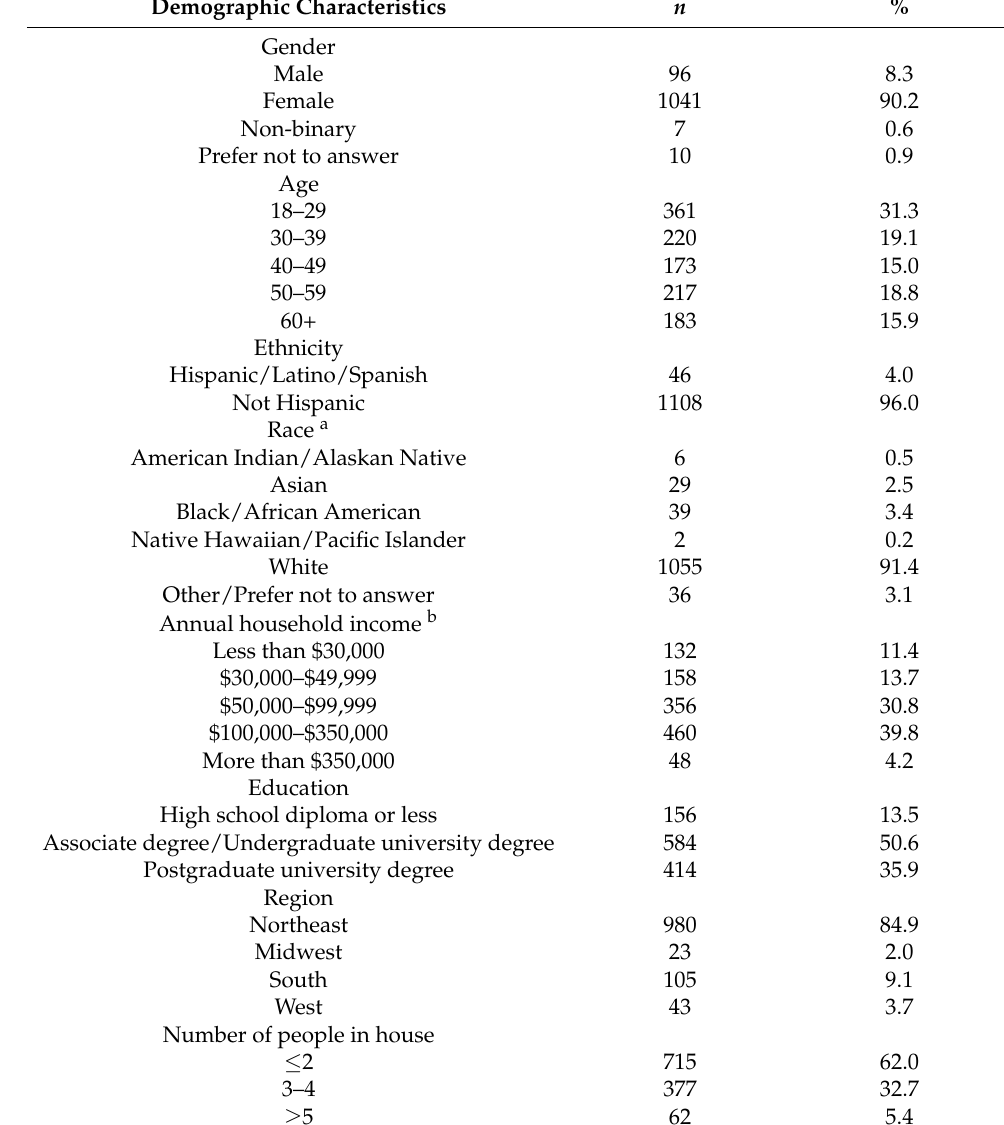
Table 1. Demographic characteristics of the